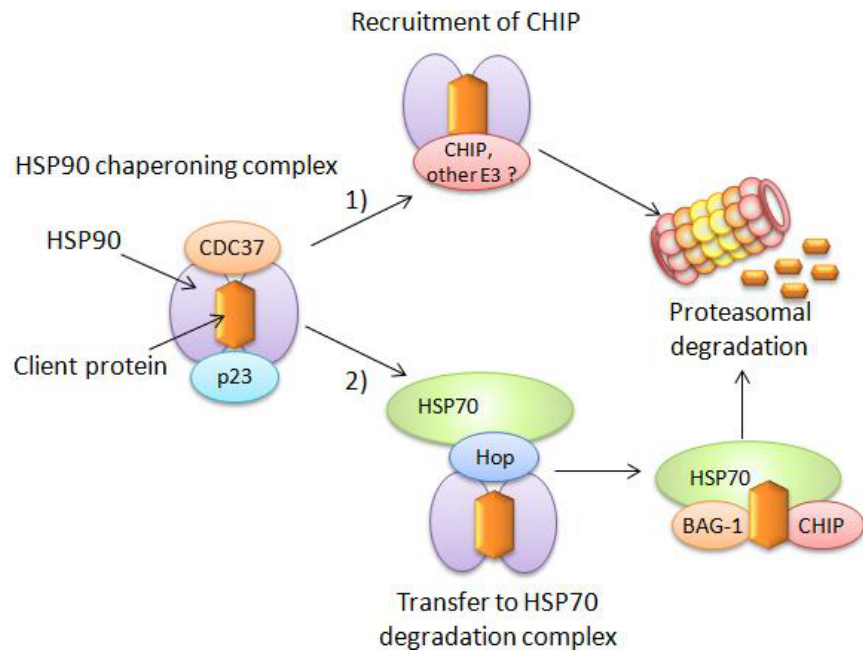
FIGURE 2 . HSP90 client proteins degradation. HSP90 client proteins are stabilized in an HSP90 chaperone complex that includes the cochaperones p23 and CDC37. When the protein fails to fold properly or after treatment with HSP90 inhibitors, the client protein is ubiquitinated and targeted to the proteasome. This can be done either (1) by the recruitment of CHIP or another E3 ligase on the HSP90 complex or (2) by the transfer of the client protein to the HSP70 degrading